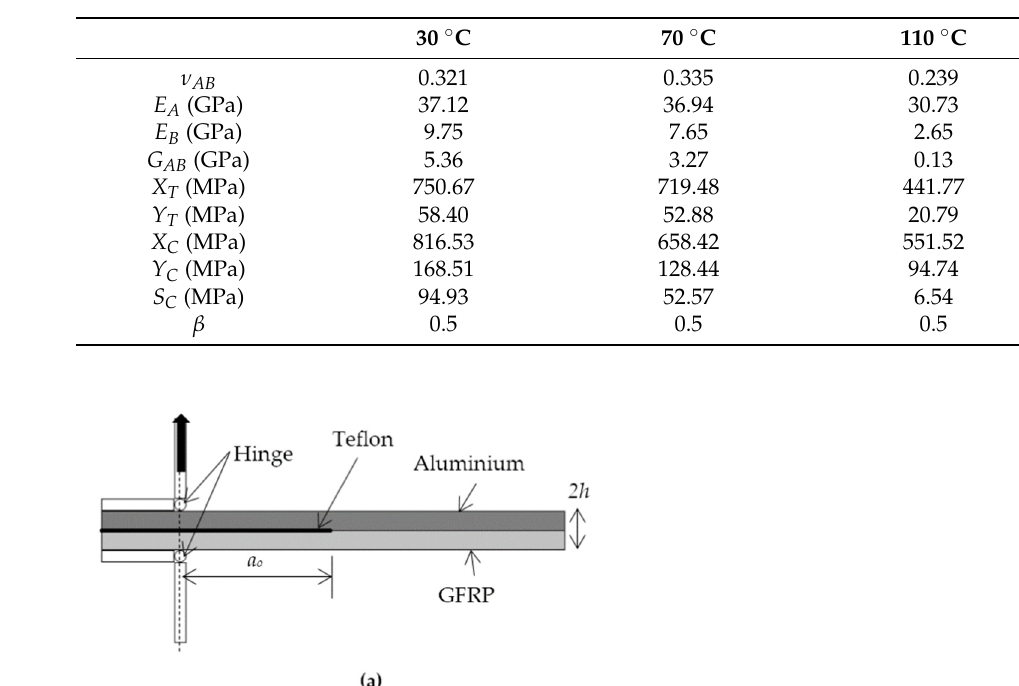
Table 2. Material properties of glass fibre-reinforced polymer (GFRP) for Chang–Chang failure criterion [28].